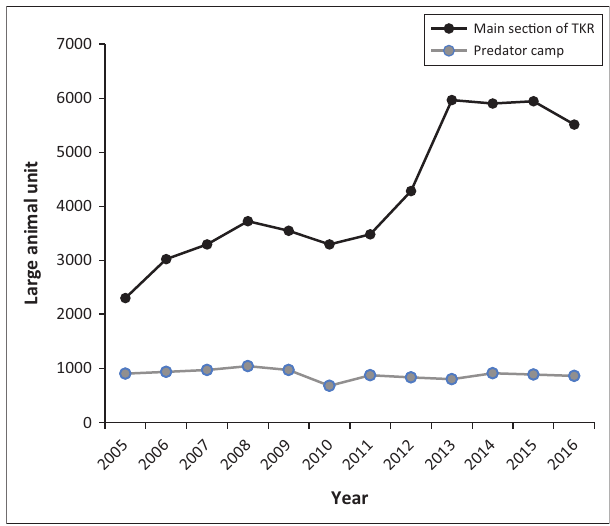
FIGURE 5: Large animal units for two management areas within the Tswalu Kalahari Reserve for the period 2005–2016. Large animal units were estimated from annual aerial count data and large animal units values for the herbivores, after Van Rooyen (2010).